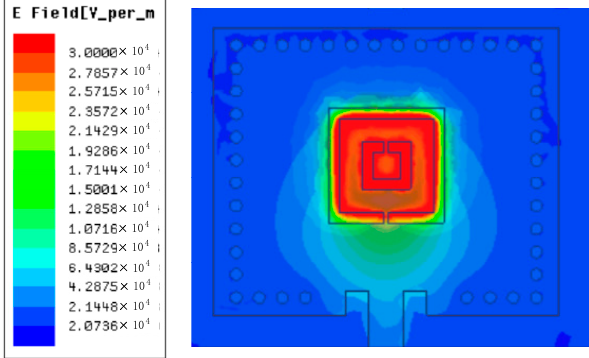
Figure 4. Simulated magnitude electric field distributions of CSRR-based pressure sensor.